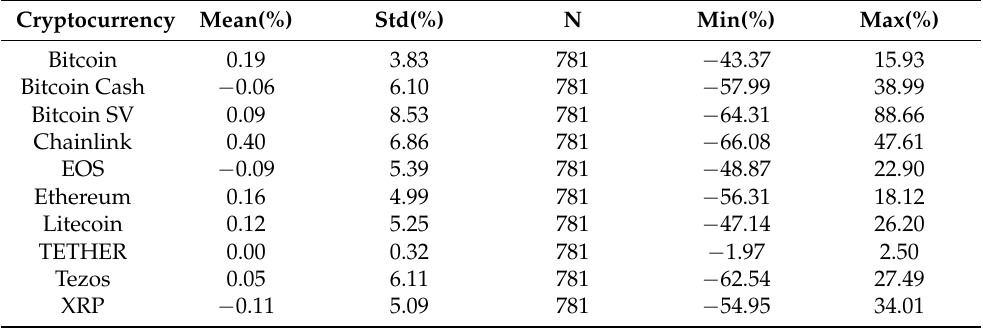
Table 1. The table presents the summary statistics of the daily return of the ten cryptocurrencies.